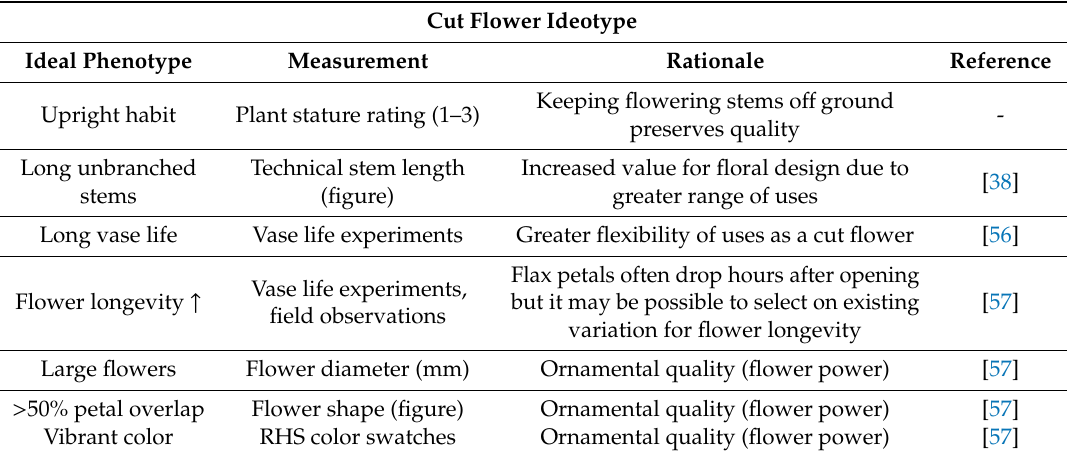
Table 2. The proposed perennial flax cut flower ideotype with the ideal phenotypic traits, the measurements required to quantify them, and the rationale for the choice of each trait.